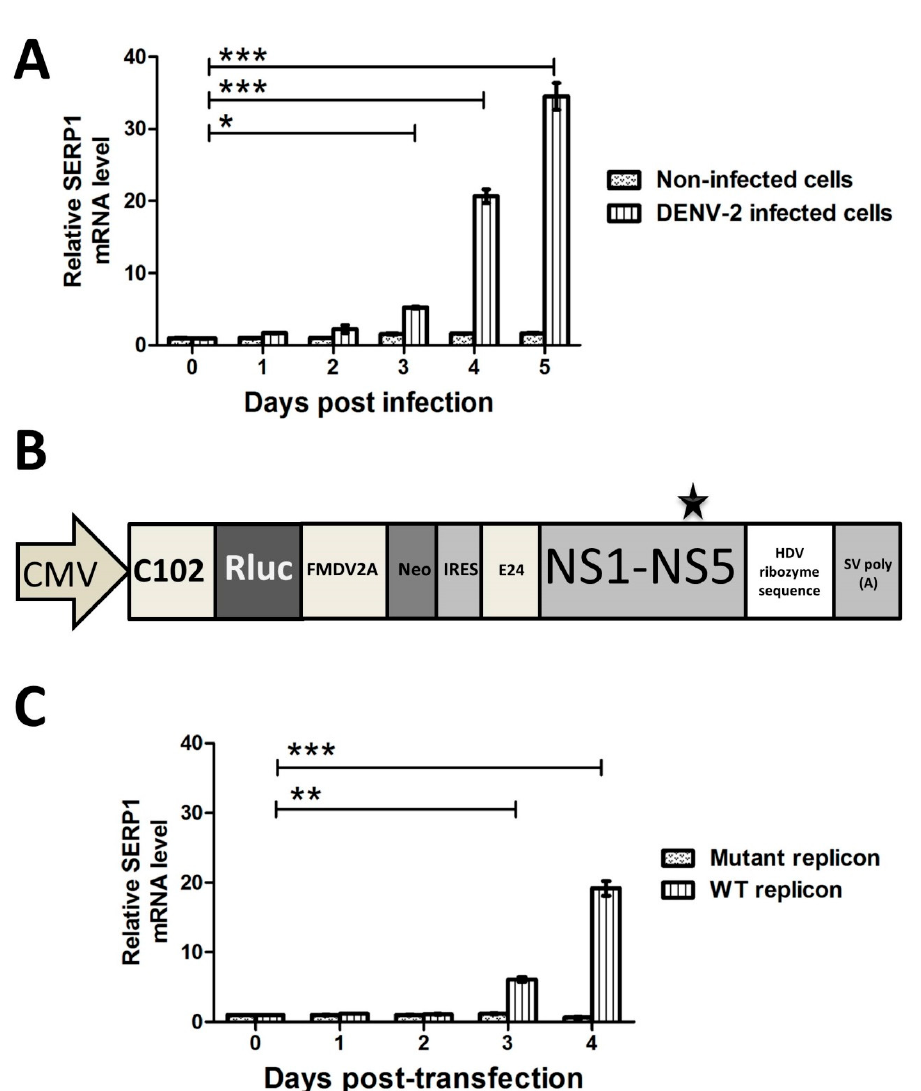
Figure 2. SERP1 expressions were induced in Huh7.5 cells upon DENV-2 infection and wild-type (WT) replicon transfection. ( A ) The Huh7.5 cells were uninfected or infected with DENV-2 at an MOI = 1. The quantification of SERP1 transcripts was performed by RT-qPCR at 0, 1, 2, 3, 4, and 5 d.p.i. The relative quantitative values of the SERP1 gene were normalized to the level of β -actin. *, p < 0.05; ***, p < 0.001 (Student's t -test). ( B ) Schematic representation of the DNA-launched DENV-2 reporter replicon pCMV-DV2Rep, which was used in a transient replicon assay. The transcriptional expression of the replicon RNA is under the control of the CMVmin promoter, and the 3’ terminus of the transcript is processed by hepatitis delta virus (HDV) ribozyme sequences. The N-terminal 102 amino acids of the C protein (C102), the Renilla luciferase gene (Rluc), the FMDV2A cleavage site, a neomycin resistance gene (Neo), an internal ribosome entry site (IRES) element, the C-terminal 24 amino acids of E (E24), the entire NS protein region (NS1 to NS5), the HDV ribozyme sequence, and the SV40 poly(A) signal sequence are indicated. The star represents the replication-defective mutant— a replicon with an inactivating mutation (Gly–Asp–Asp (GDD) to Gly–Ala–Ala (GAA) at the amino acids 662–664 of NS5) in the catalytic site of the NS5 RNA-dependent RNA polymerase (RdRp) was